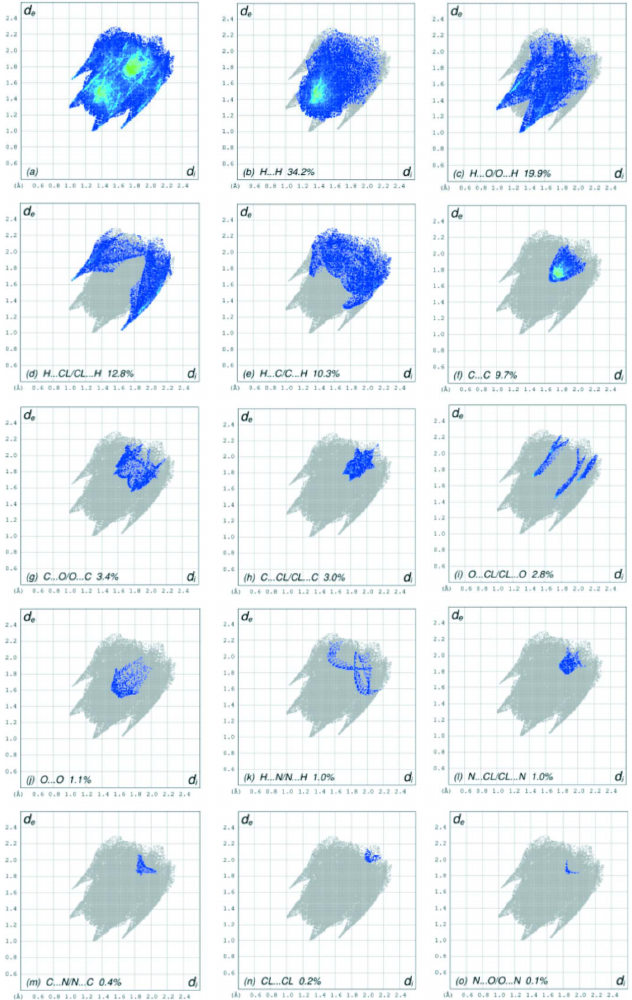
Figure 5 The full two-dimensional fingerprint plots for the title compound, showing ( a ) all interactions, and delineated into ( b ) H (cid:3)(cid:3)(cid:3) H, ( c ) H (cid:3)(cid:3)(cid:3) O/ O (cid:3)(cid:3)(cid:3) H, ( d ) H (cid:3)(cid:3)(cid:3) Cl/Cl (cid:3)(cid:3)(cid:3) H, ( e ) H (cid:3)(cid:3)(cid:3) C/C (cid:3)(cid:3)(cid:3) H, ( f ) C (cid:3)(cid:3)(cid:3) C, ( g ) C (cid:3)(cid:3)(cid:3) O/O (cid:3)(cid:3)(cid:3) C, ( h ) C (cid:3)(cid:3)(cid:3) Cl/Cl (cid:3)(cid:3)(cid:3) C, (i) O (cid:3)(cid:3)(cid:3) Cl/Cl (cid:3)(cid:3)(cid:3) O, ( j ) O (cid:3)(cid:3)(cid:3) O, ( k ) H (cid:3)(cid:3)(cid:3) N/N (cid:3)(cid:3)(cid:3) H, ( l ) N (cid:3)(cid:3)(cid:3) Cl/Cl (cid:3)(cid:3)(cid:3) N, ( m ) C (cid:3)(cid:3)(cid:3) N/N (cid:3)(cid:3)(cid:3) C, ( n ) Cl (cid:3)(cid:3)(cid:3) Cl and ( o ) N (cid:3)(cid:3)(cid:3) O/O (cid:3)(cid:3)(cid:3) N interactions. The d i and d e values are the closest internal and external distances (in A˚ ) from given points on the Hirshfeld